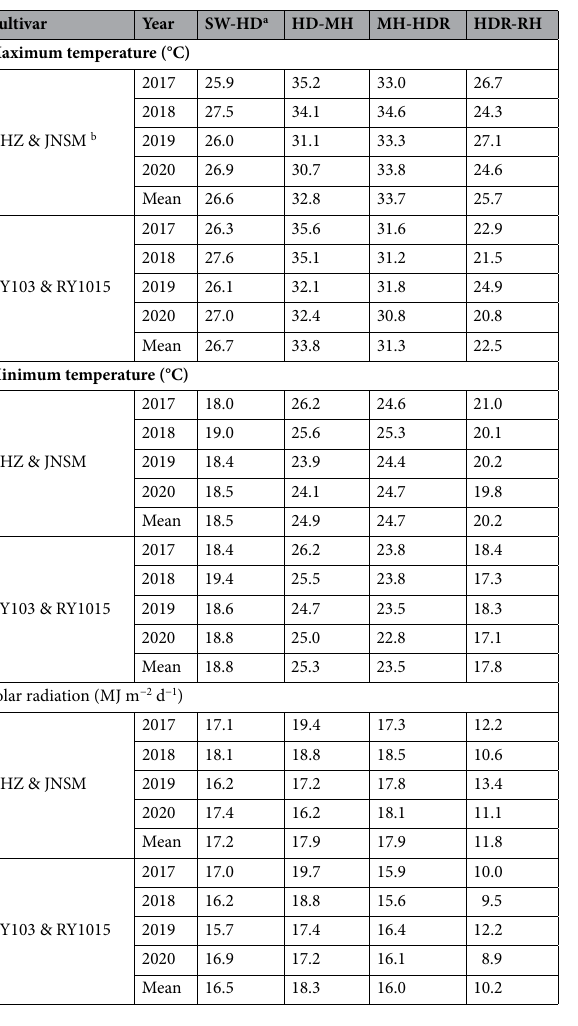
heading to harvest of the main rice crop; MH-HDR, from harvest of the main rice crop to heading of the ratoon rice; HDR-RH, from heading of the ratoon rice to harvest of the ratoon rice. b HHZ, JNSM, NY103 and RY015 are Huanghuazhan, Jinnongsimiao, Nei6you103 and Rongyou1015,